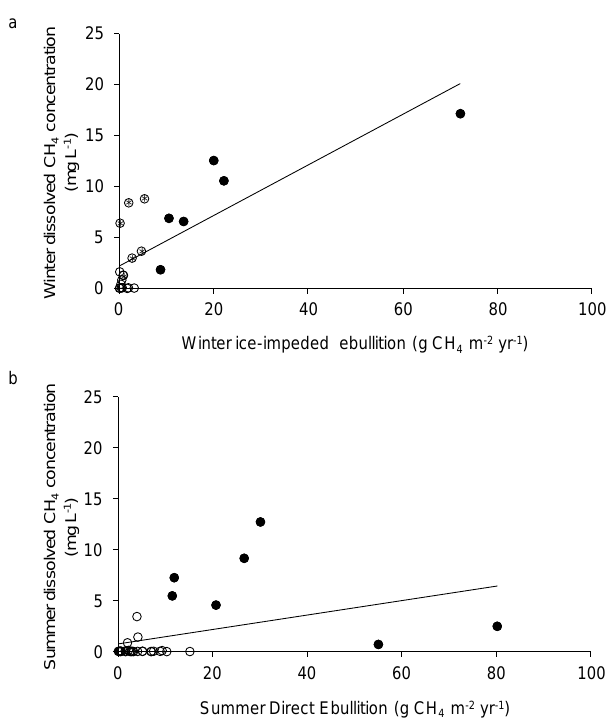
Figure 6. Dissolved CH 4 concentrations measured in lake bot- tom water vs. winter ice-impeded ebullition in winter (a) and di- rect ebullition in summer (b) . The Spearman coefficients, r s = 0 . 72 and r s = 0 . 42, indicate a strong positive correlation and a weak positive correlation in winter and summer, respectively. All lakes were considered a single population; however, yedoma lakes (closed circles) had higher concentrations of lake-bottom dissolved CH 4 (mean ± SD: 9.3 ± 5.4 winter, 6.7 ± 4.1mgL − 1 summer) and a higher density of ebullition seeps (Sect. 3.2) than non-yedoma lakes (open circles; 2.1 ± 3.0 winter, 0.3 ± 0.7mgL − 1 summer). We ob- served relatively high concentrations of dissolved CH 4 in some non- yedoma lakes in winter due to dissolved gas exclusion during ice formation in shallow lakes that nearly froze to the lake bed, in- dicated by “ ∗ ”. Excluding lakes that nearly froze to the lake bed, the mean dissolved CH 4 in the remaining non-yedoma lakes was 0.3 ± 0.5mgL − 1 in